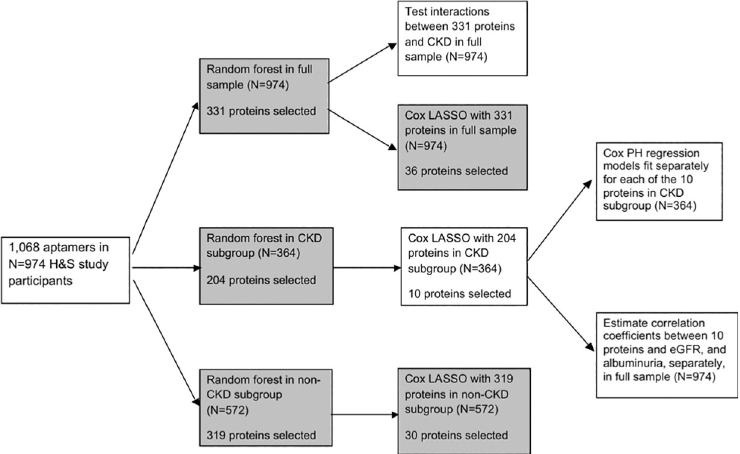
Fig 1. Analytic plan (See attached file). This flowchart depicts our analytic plan. Results of analyses in boxes shaded grey were performed but had lower relevance to the project Aims and thus are not included in the manuscript. H&S: Heart and Soul. LASSO: Least Absolute Shrinkage and Selection Operator. PH: proportional